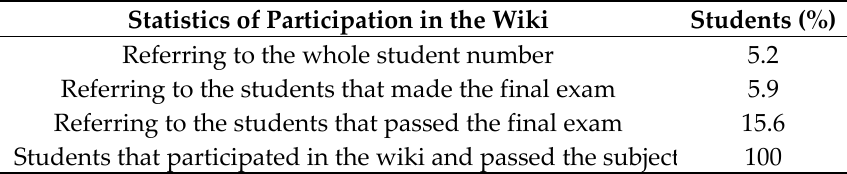
Table 1. Statistics of participation of the students in the